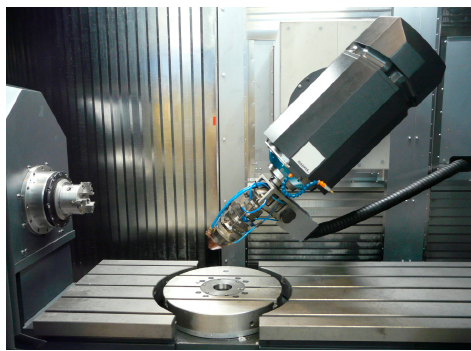
/ 1600 hybrid additive / subtractive hybrid machine. Figure 1. ZVH 45/1600 hybrid additive/subtractive hybrid machine . Figure 1. ZVH 45